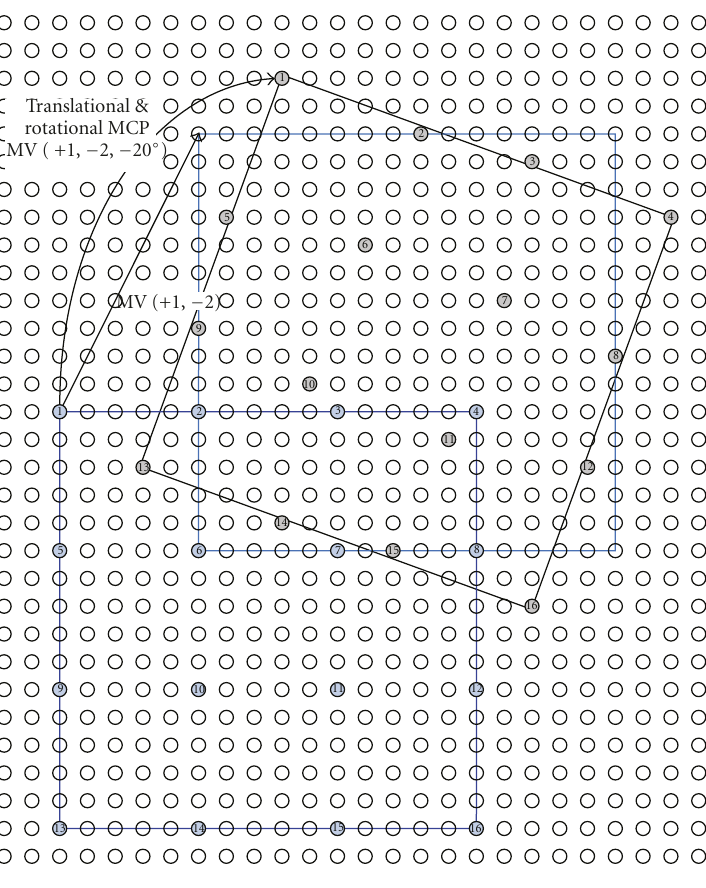
Figure 3: An example of translational and rotational MCP implemented by special subsampling on the interpolated reference frame.